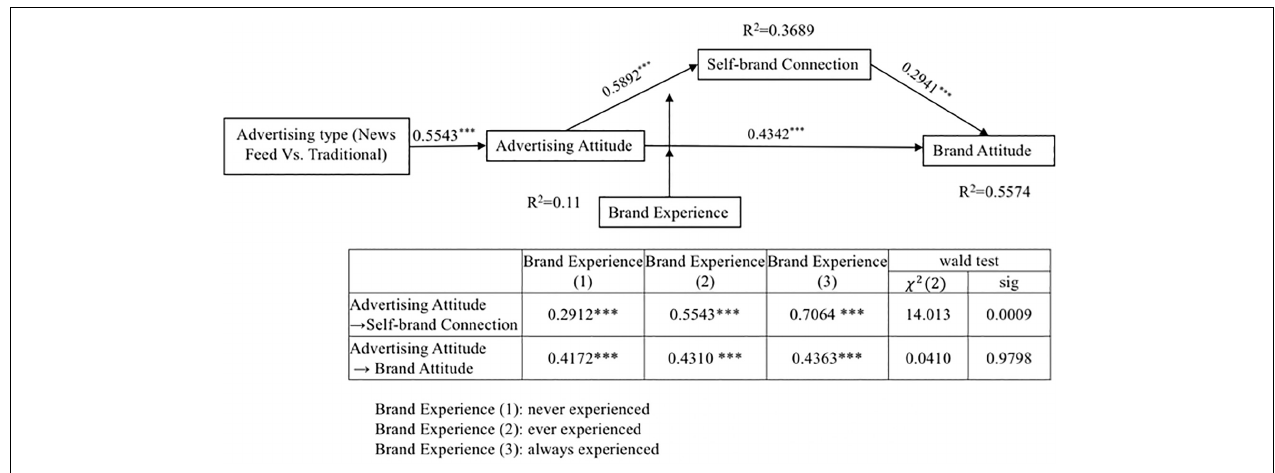
FIGURE 3 | Relationships between constructs. *** p < 0.01, ** p < 0.05.